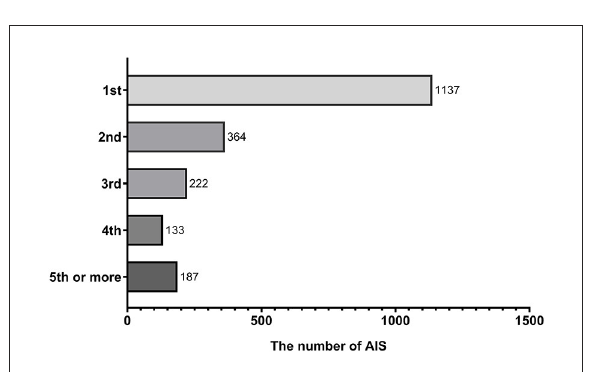
FIGURE4 The number of acute ischemic strokes in a different sequence of diagnosis.